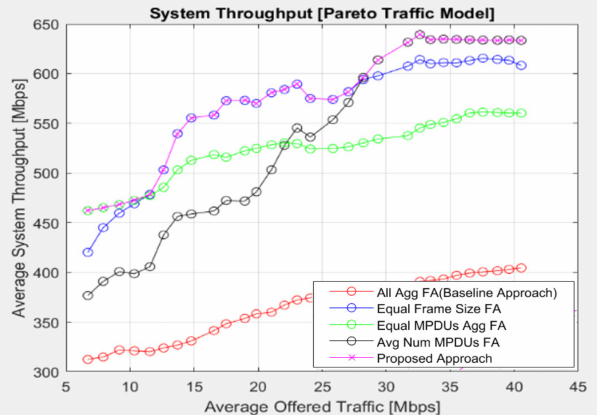
Figure 7. Performance of average system throughput with increasing offered traffic load using Pareto traffic